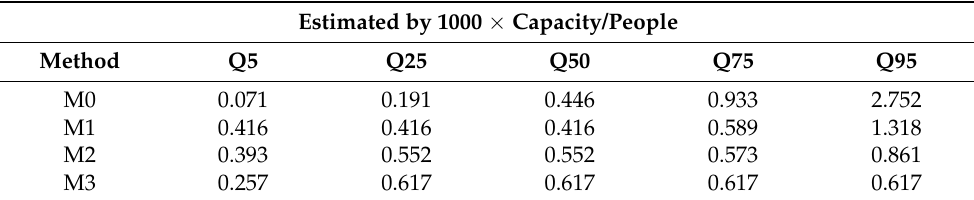
Table 6. Quintile accessibility of community care resources measured through methods